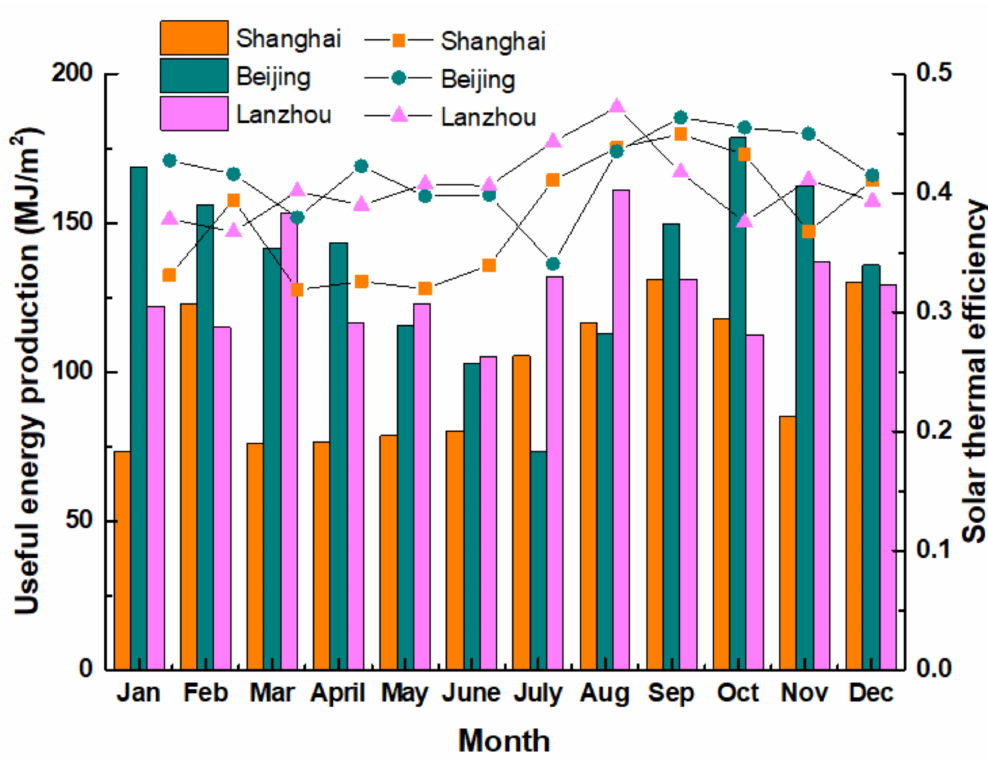
Figure 6. Monthly hot water supply in three